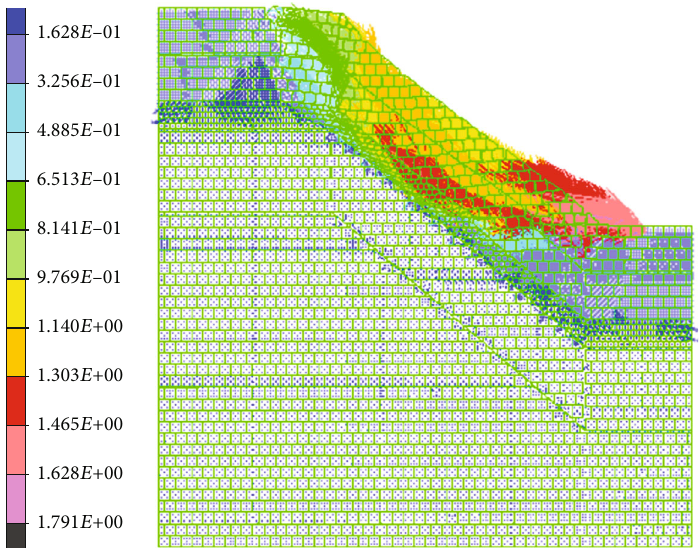
Figure 14: Displacement vector diagram when running 160,000